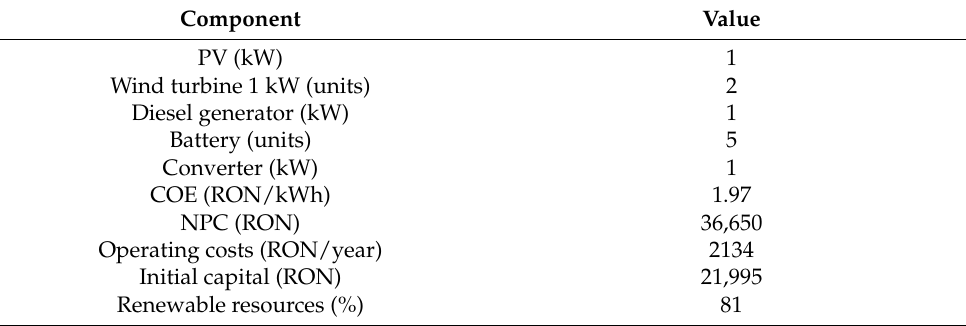
Table 3. The simulation results using the HOMER simulator.